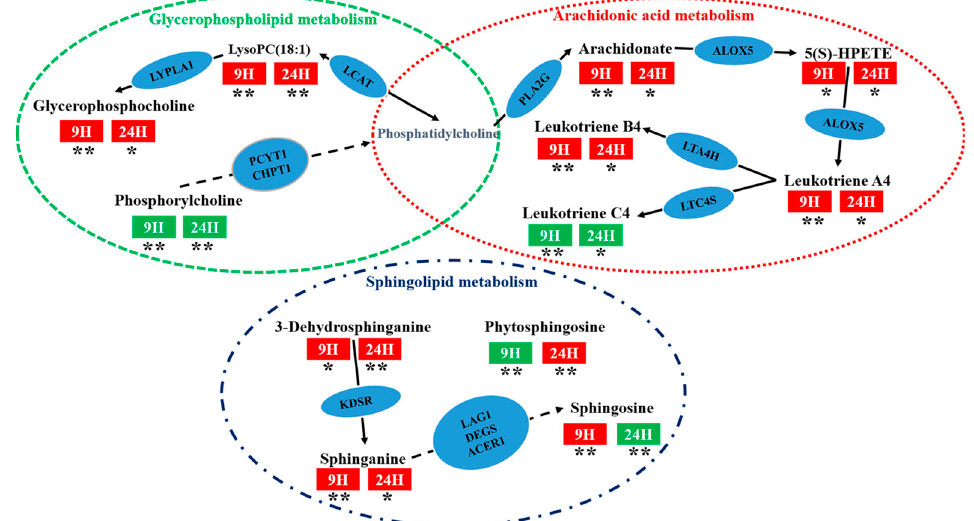
Figure 8. The metabolic pathway networks of particularly significant potential biomarkers for the therapeutic effect of p-b4 on MSU crystal-induced GA rats. The word in blue ovals means enzyme according to KEGG pathway database; the word in red and green rectangles means the sampling time of serum; red indicates an up-regulation of metabolites and green indicates a down-regulation of metabolites (GA model group VS P-b4 group); * means p < 0.05, ** means p < 0.01.